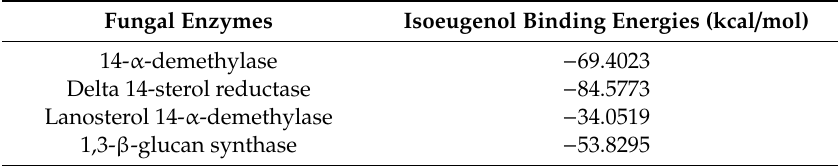
Table 4. Isoeugenol binding energies (kcal / mol) with selected fungal